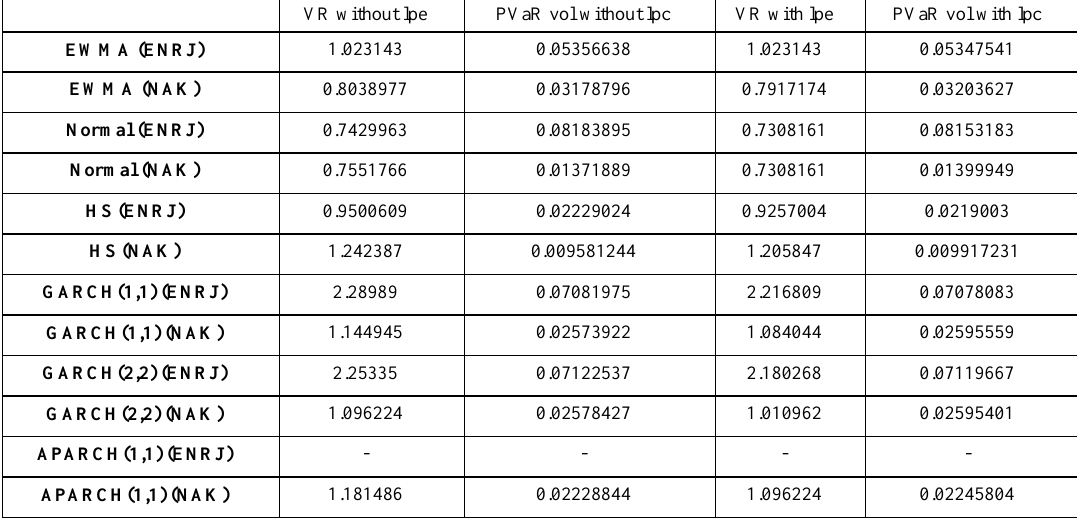
Table 9. Backtesting with and without lpc for PVaR